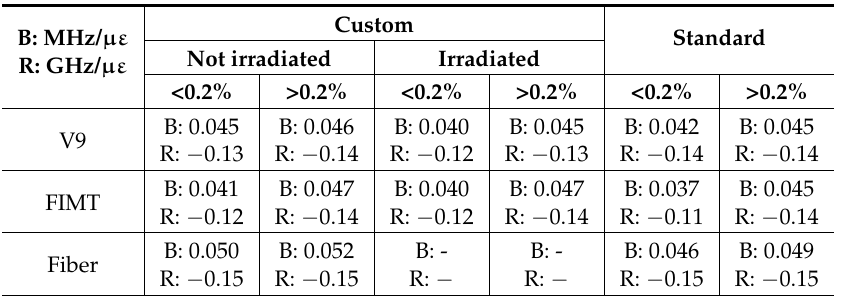
Table 2. Strain sensitivity coefficients of the different tested